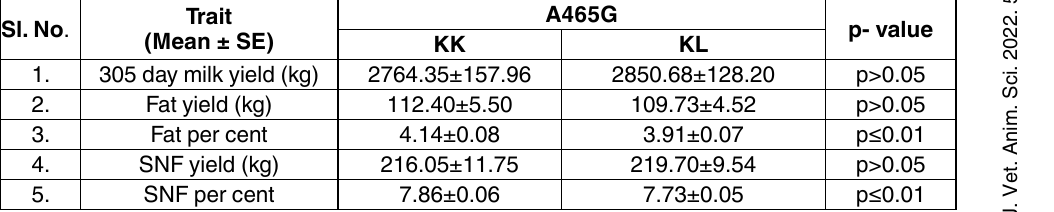
Table 2. Effect of SNP A465G on milk production traits in crossbred cattle of Kerala sl. No